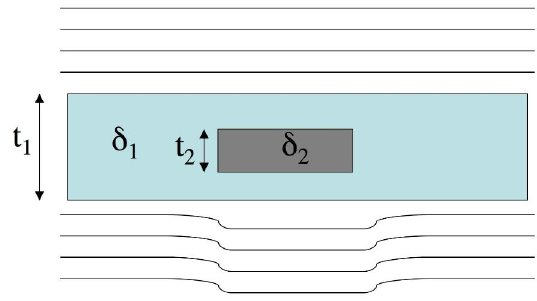
Figure 2. Working principle of phase contrast imaging. An initially perfectly plane wavefront, with all waves “in phase”, becomes distorted because waves have a higher speed inside the detail than outside (see text).